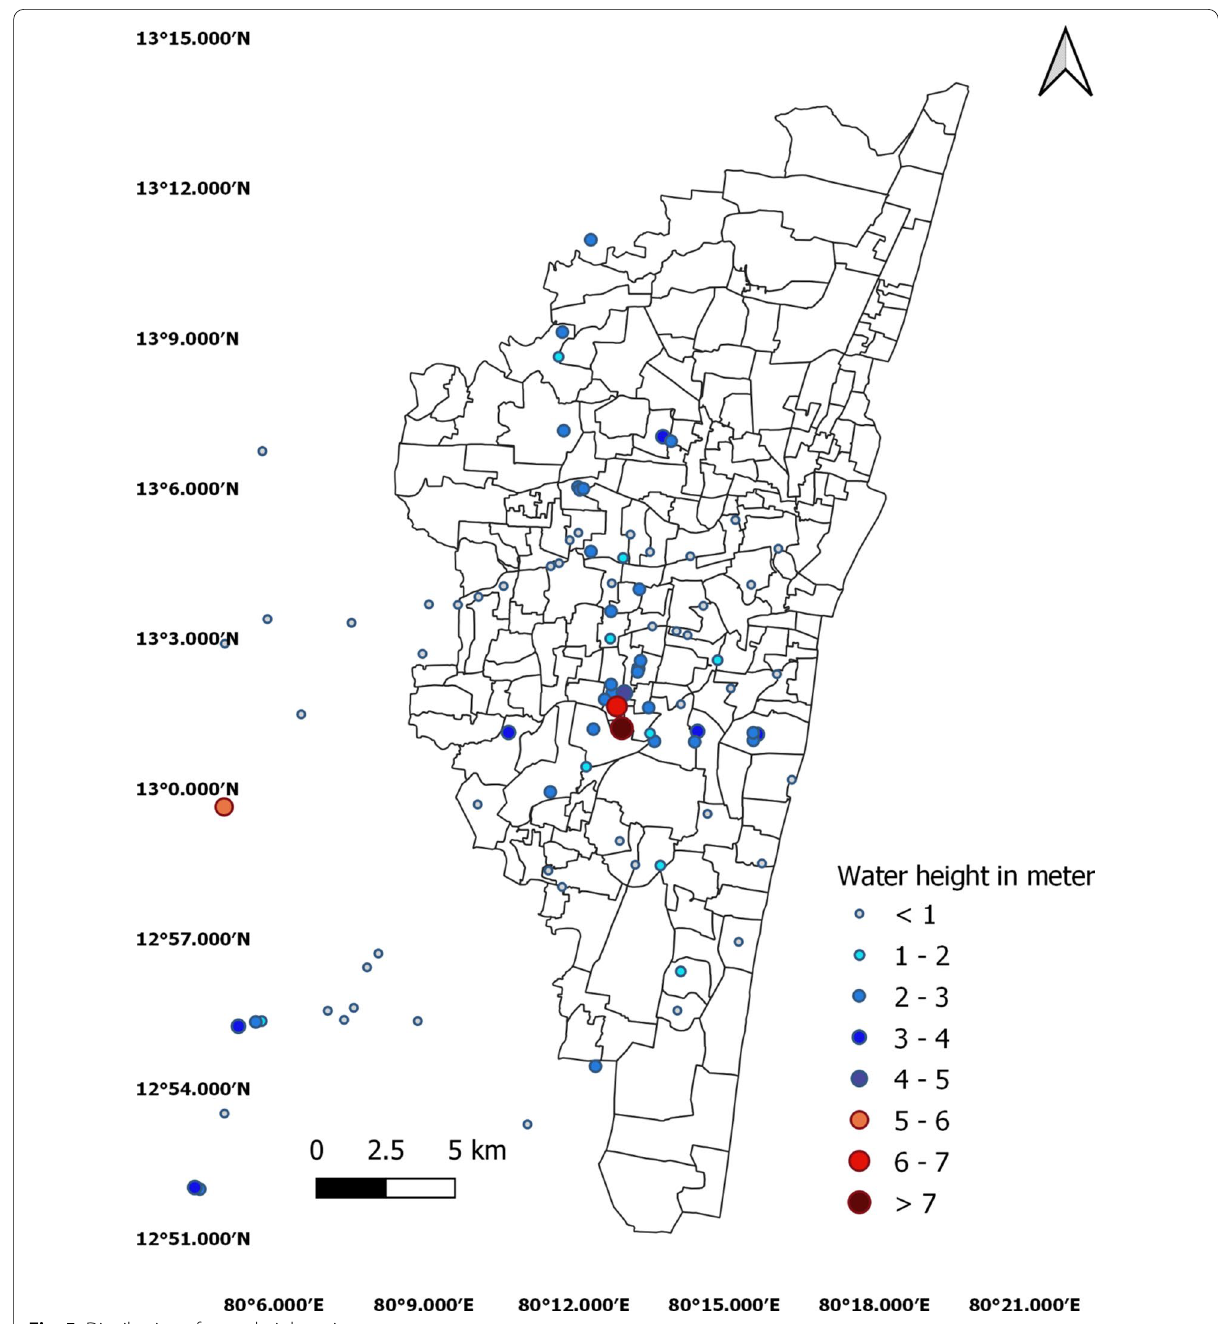
Fig. 5 Distribution of water height